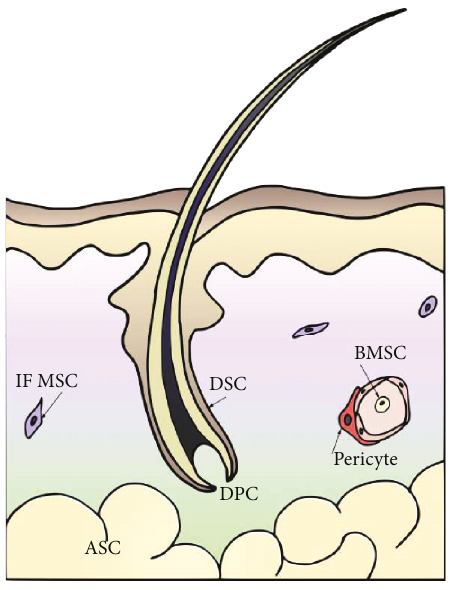
Figure 2: The MSCs involved in normal wound healing. ASC =adipose-derived MSC; BMSC =bone marrow-derived MSC; DPC=dermal papilla cell; DSC=dermal sheath cell; IF MSC=interfollicular